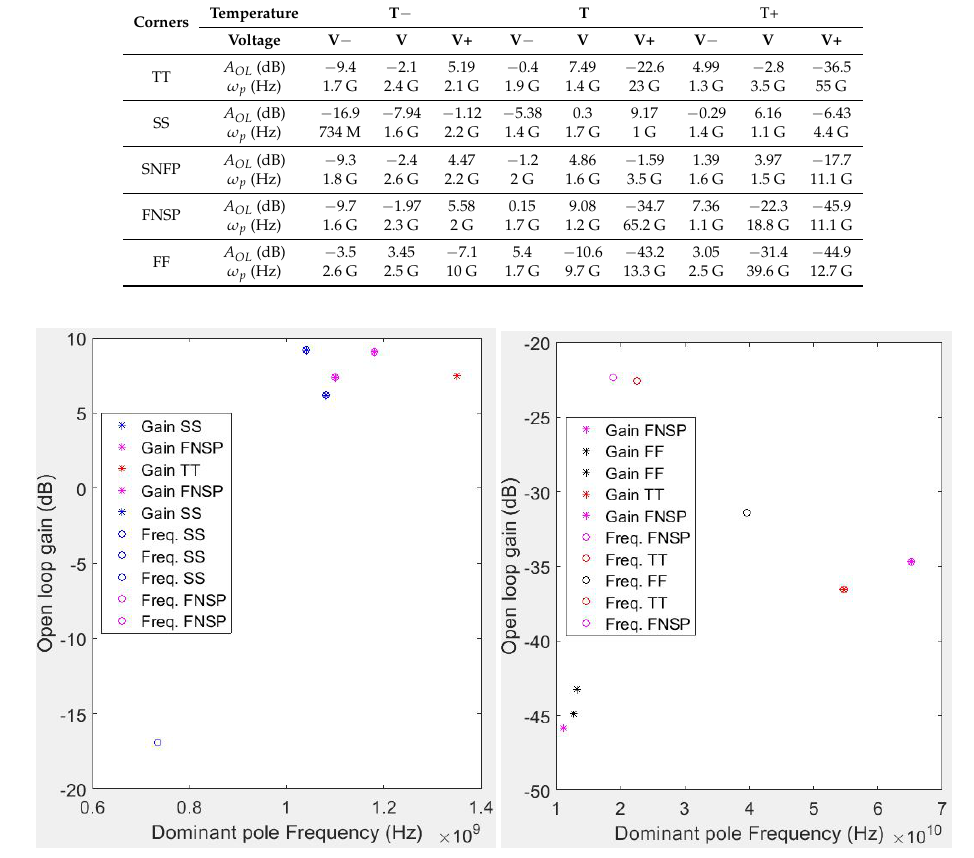
Table 2. Open-loop gain and dominant pole frequency over PVT variations with V ctrl = − 0.2 V.